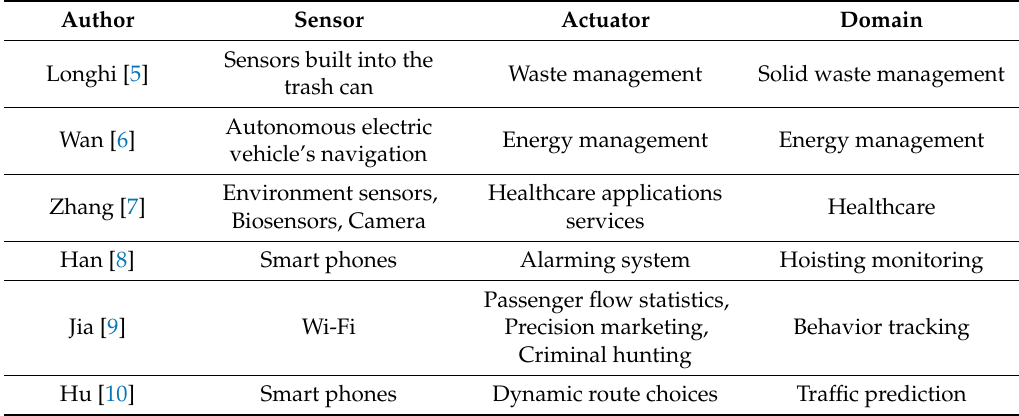
Table 1. Summary of related